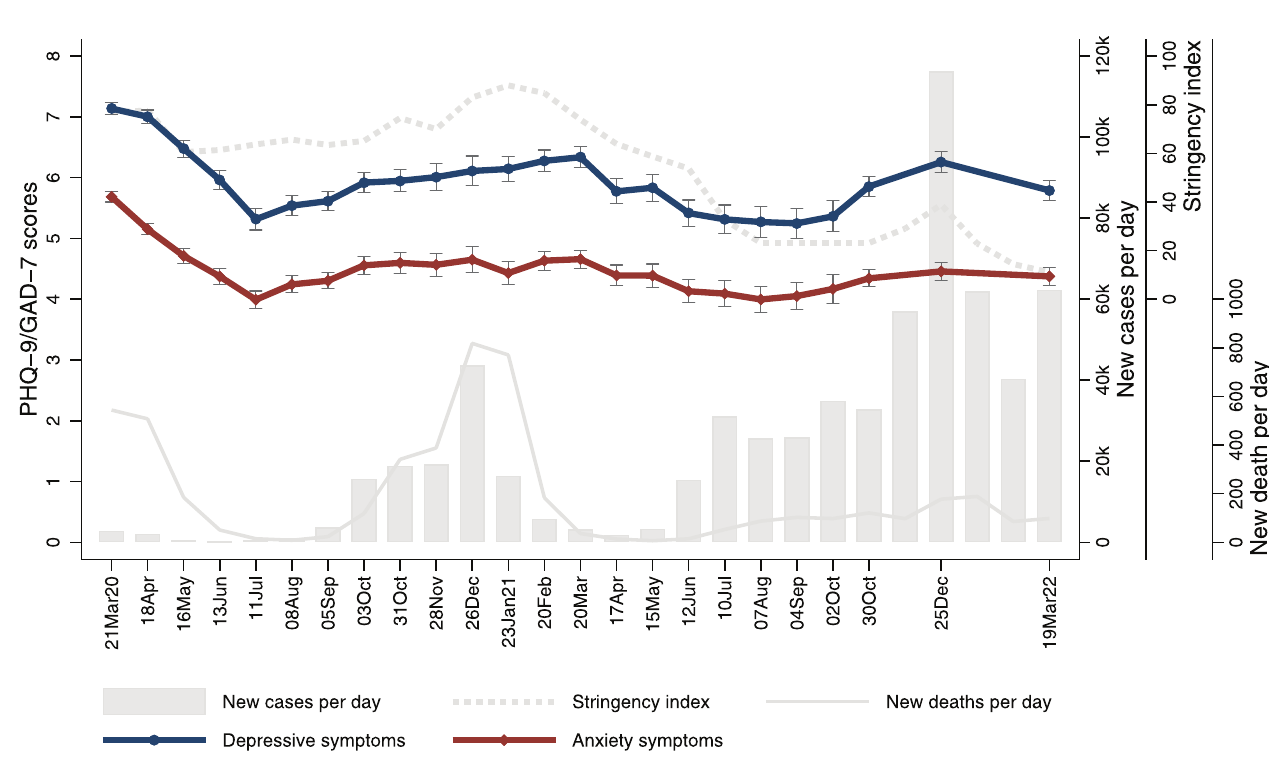
Fig 1. Trends of depressive and anxiety symptoms (weighted means) in relation to policy responses (stringency index) and pandemic intensity (daily COVID-19 cases and deaths) between March 2020 and April 2022. COVID-19, Coronavirus Disease 2019; GAD, generalized anxiety disorder.